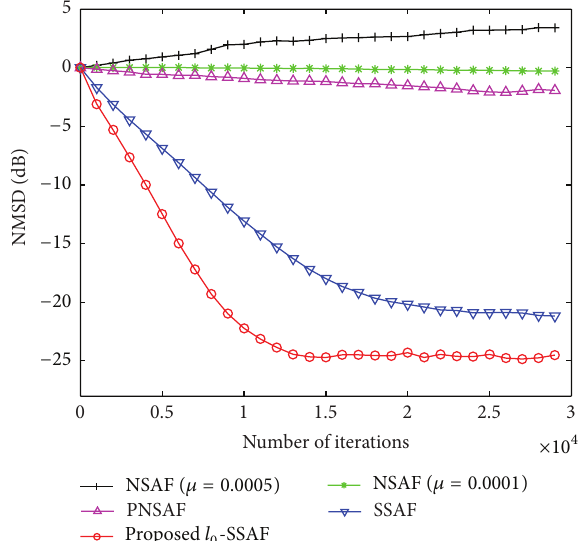
Figure 2: NMSD learning curves of the NSAF, PNSAF, SSAF, and 𝑁 = 4 , SIR = −30 dB, input: Gaussian AR (1) 𝑙 0 -SSAF algorithms [ with pole at 0.9].